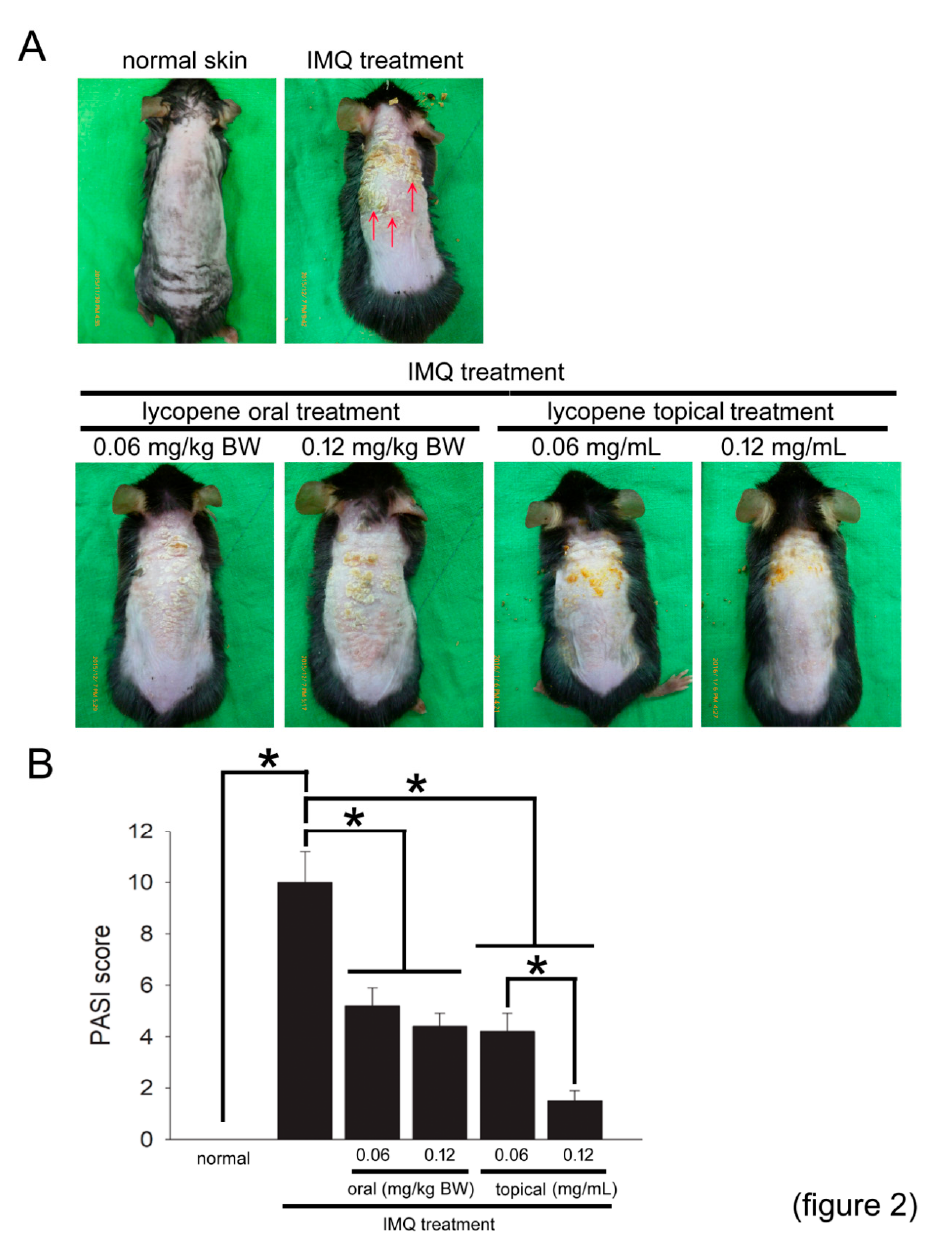
Figure 2. Lycopene improves psoriasis-like phenomena in mice. ( A ) Mice in each group were presented in representative photos. Representative photos of the mice that received IMQ treatment with or without oral administration of and topical treatment with lycopene. The arrows indicate psoriasis-like and scared skin. ( B ) The PASI score is shown as a bar graph. The results are expressed as the mean ± SD. A * p < 0.05 was considered statistically